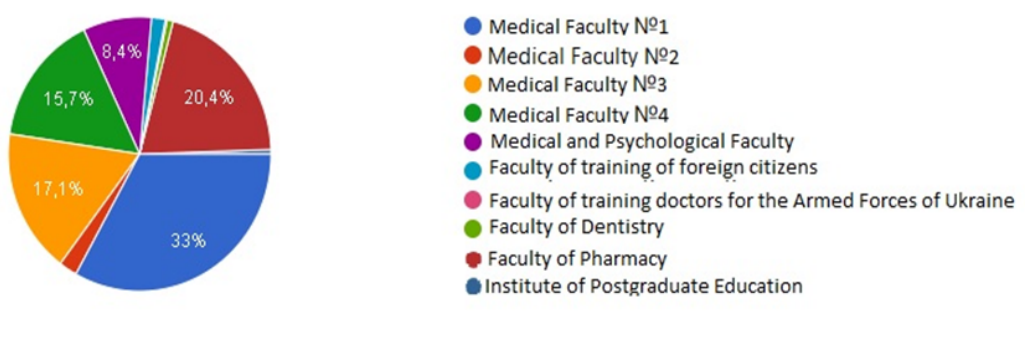
Figure 7: Distribution of respondents depending on the